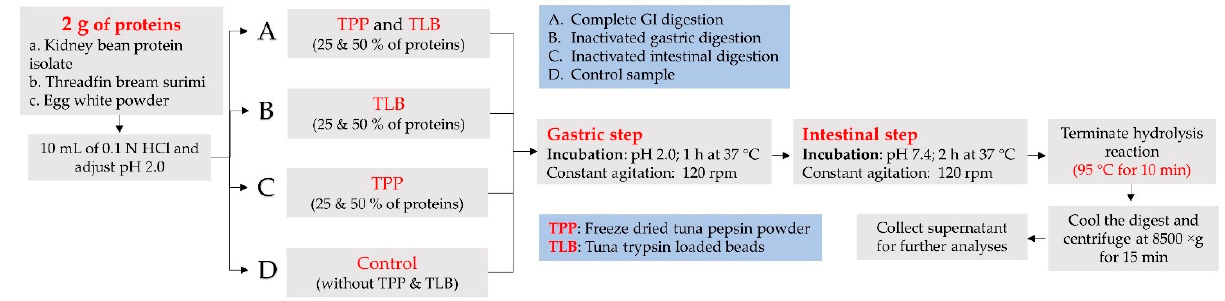
Figure 2. Flow diagram of simulated in vitro gastrointestinal (GI) digestion of some proteins by freeze-dried tuna pepsin powder (TPP) and trypsin loaded beads (TLB).